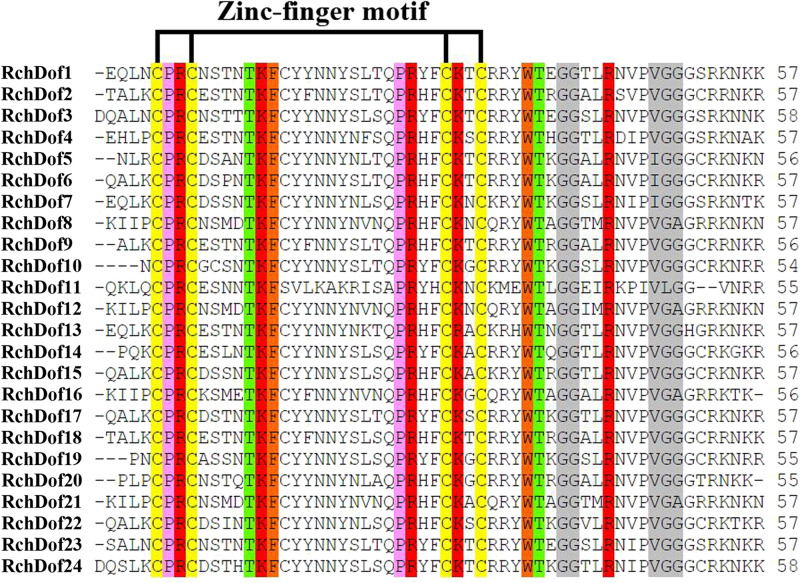
Dof domain sequence alignment of rose Dof proteins. Only the conserved Dof domain residue is currently shown. The four cysteine residues putatively responsible of the zinc-finger structure are indicated. Identical and similar amino acids are highlighted.